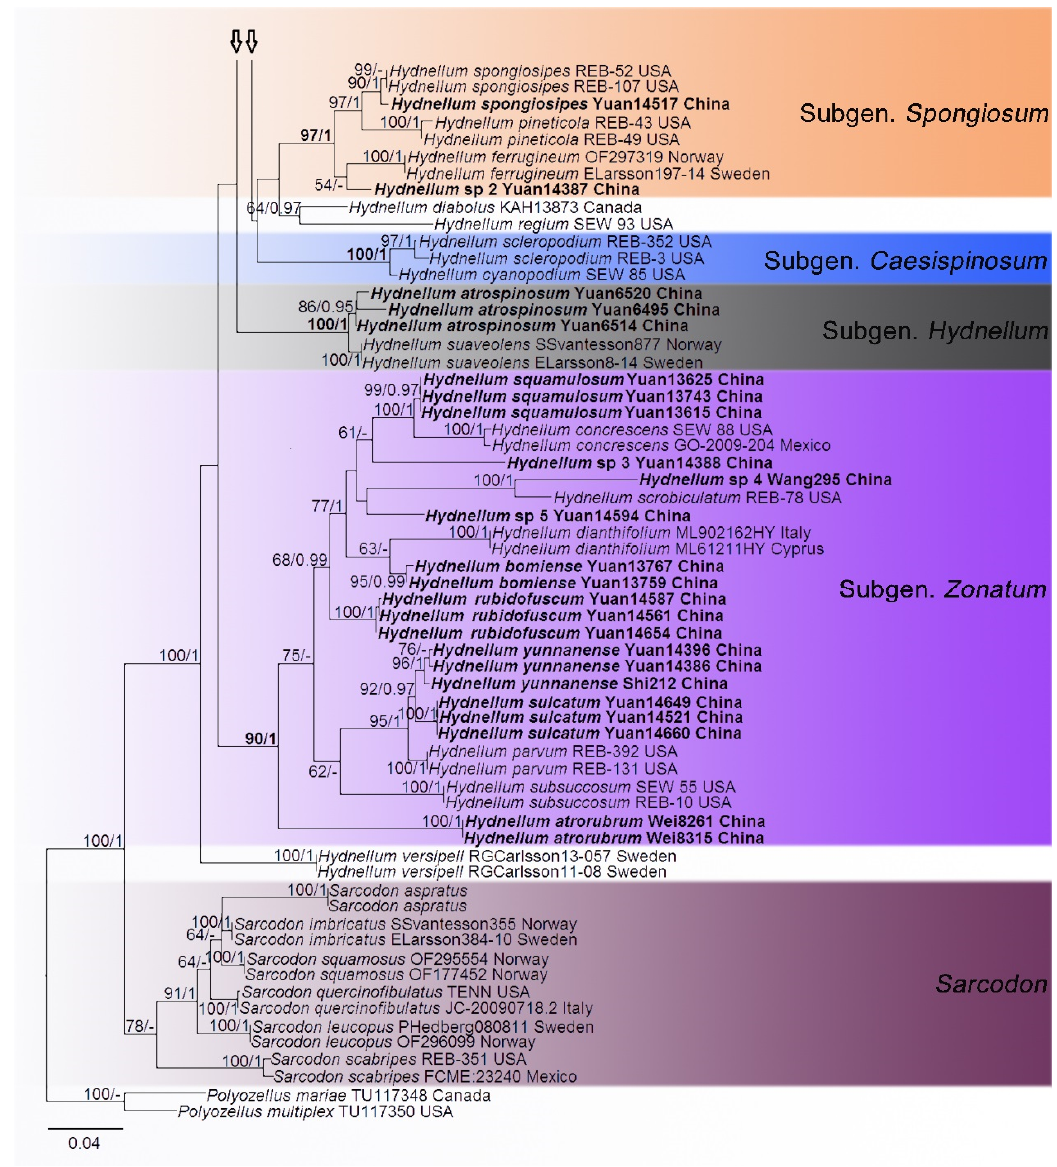
Figure 1. Maximum likelihood tree illustrating the phylogeny of Hydnellum and Sarcodon based on nLSU, ITS, SSU and RPB2 sequence datasets. Branches are labeled with maximum likelihood bootstrap support greater than 50 % and Bayesian posterior probabilities greater than 0.95. Newly sequenced collections are in bold.